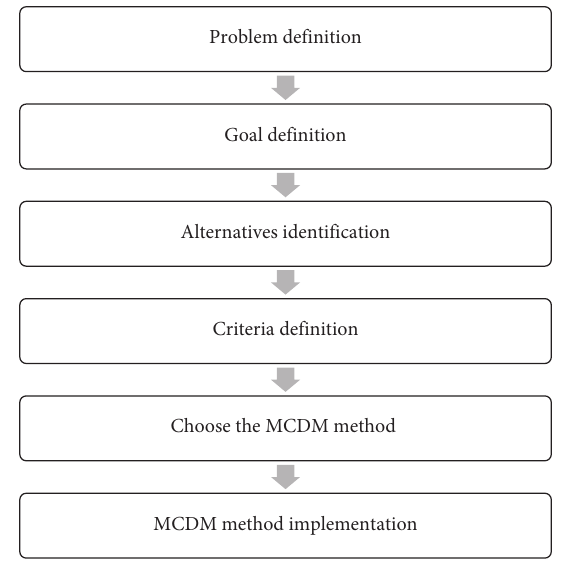
Figure 4: Steps of MCDM